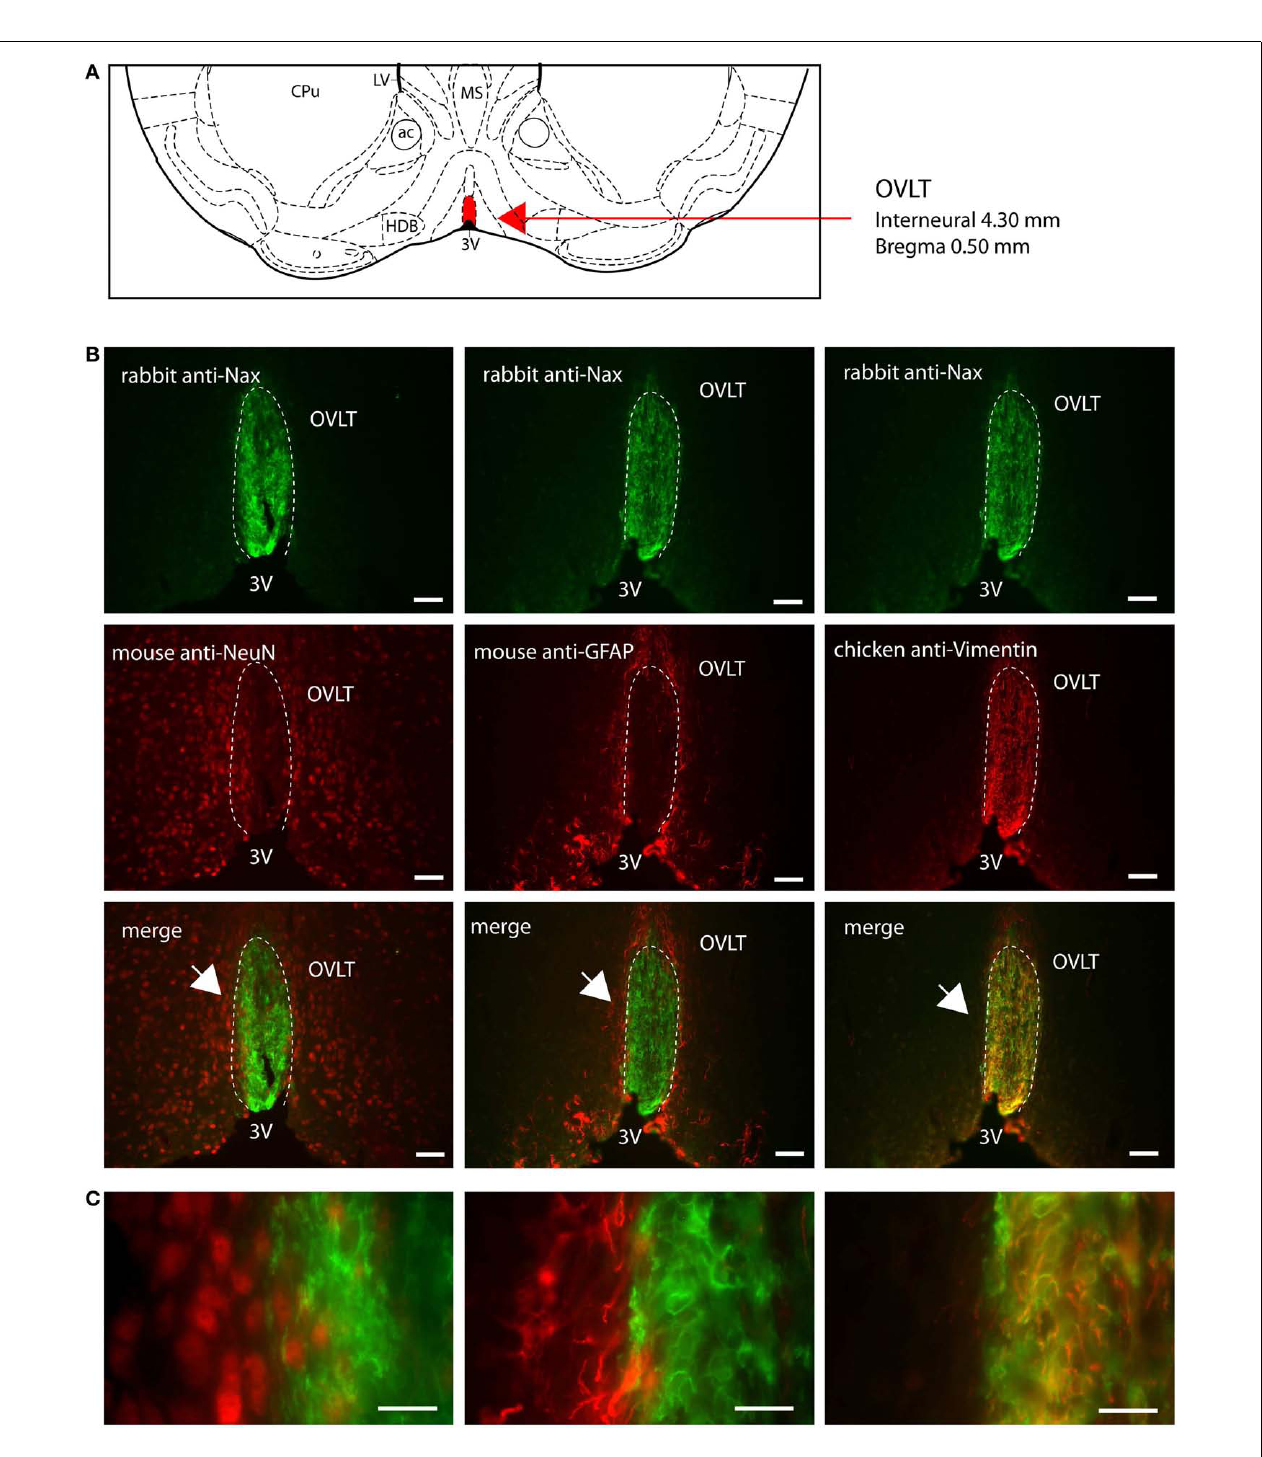
Na X immunostaining (green) was obtained from the mouse.The OVLT region is delimited by the dashed line. 3V, third ventricle.The cell type expressing Na X was identified using anti-NeuN, anti-GFAP, and anti-vimentin fluorescent immunostaining (red); scale bar: 50 µ m. (C) High magnification pictures of the staining merge; scale bar: 20 µ m.The arrow head points the top-left corner of the enlarged zone. Na X staining is only present in vimentin positive